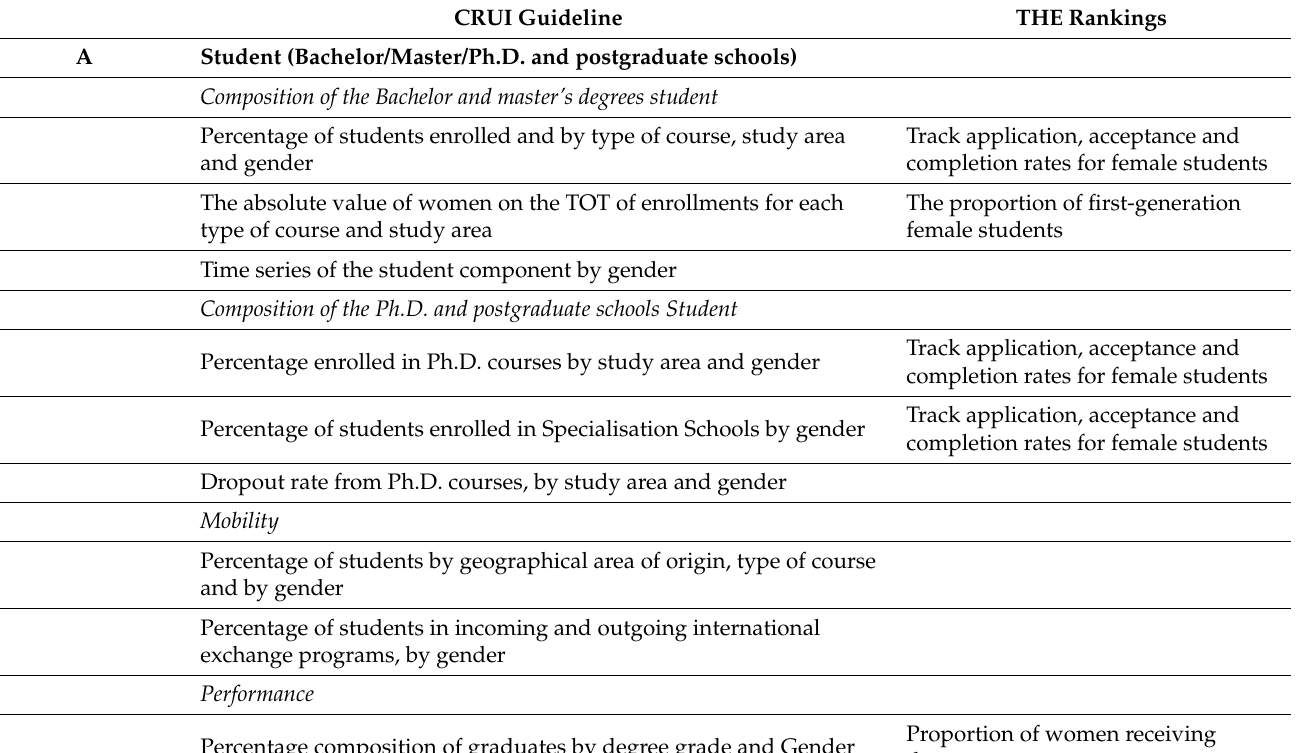
Table 1. CRUI guidelines vs. the metrics of the Times Higher Education Impact